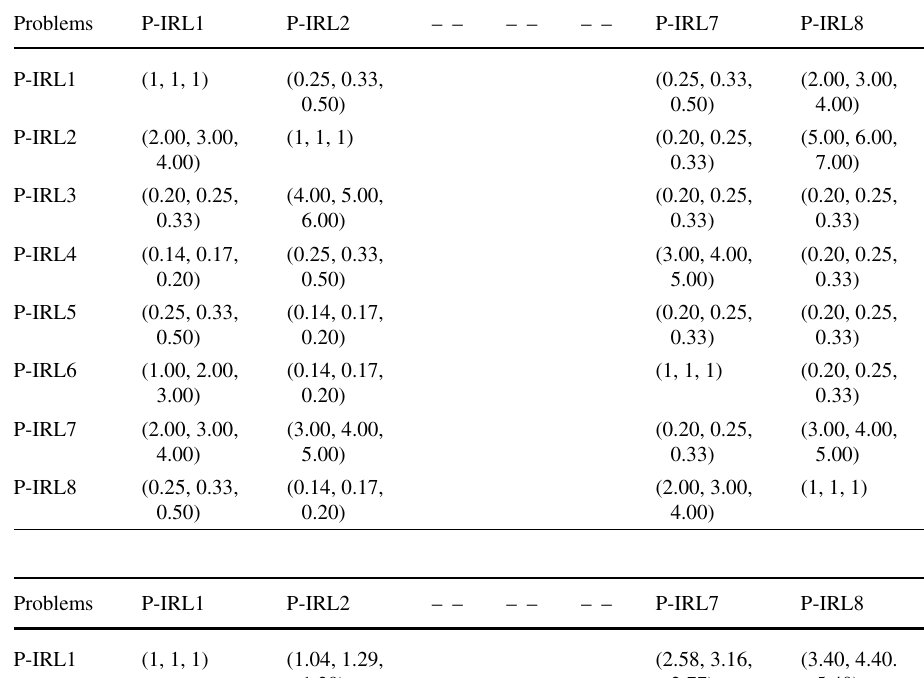
Table 5 Aggregated TFN decision matrix for IRL problems